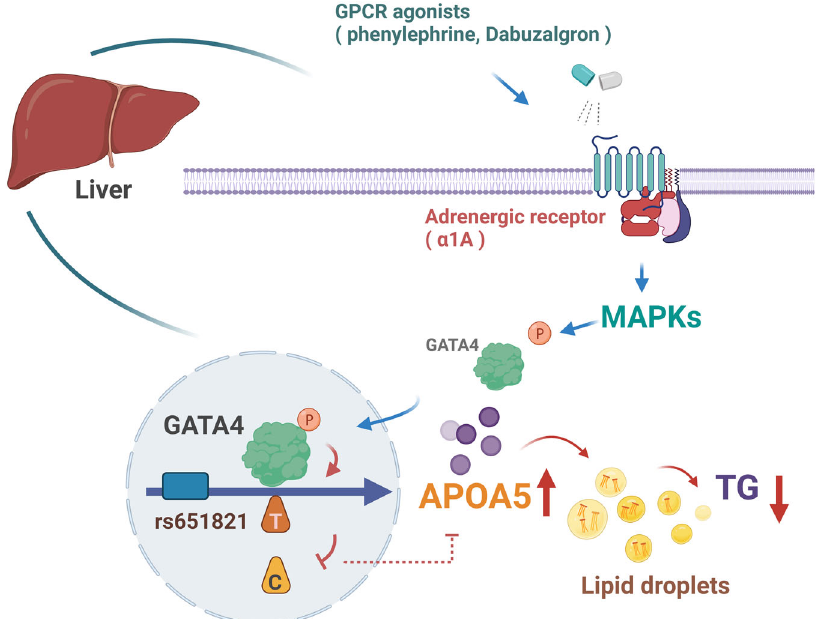
Fig. 6 Model of the regulatory mechanism for rs651821 mediating APOA5 expression through GATA4, thereby promoting TG hydrolysis in liver. The fi gure was created with